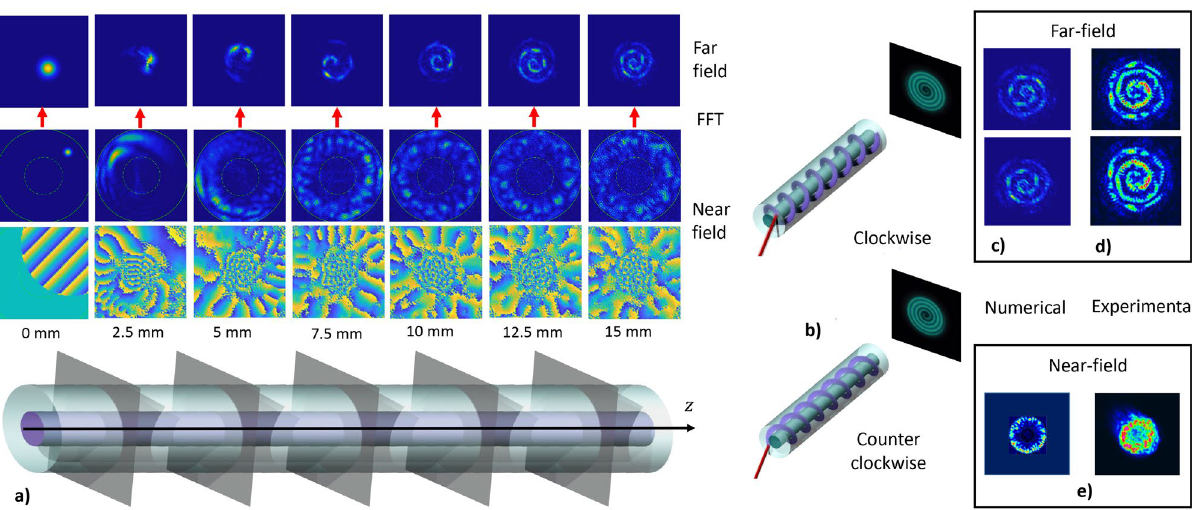
Figure 4. ( a ) Sketch of the first 1.5 cm of the fibre (bottom); The near-field (amplitude and phase) is numerically computed each 2.5 mm, corresponding to the position where the transverse planes cut the fibre (centre). The far-field is calculated as the Fourier transform of the near-field, showing spiral emission formation (top). ( b ) Tunability of optical chirality. The spiral emission ℓ sign depends on the input beam position with respect to the fibre centre. ( c ) Numerical confirmation of optical chirality inversion. ( d ) Experimental results corresponding to ( c ). ( e ) Comparison of numerical and experimental near-field intensities. All simulations and experiments were performed with an input peak power of 3 MW, a wavelength of 1030 nm, ϑ = 1.5 ◦ and ϕ = 45 ◦